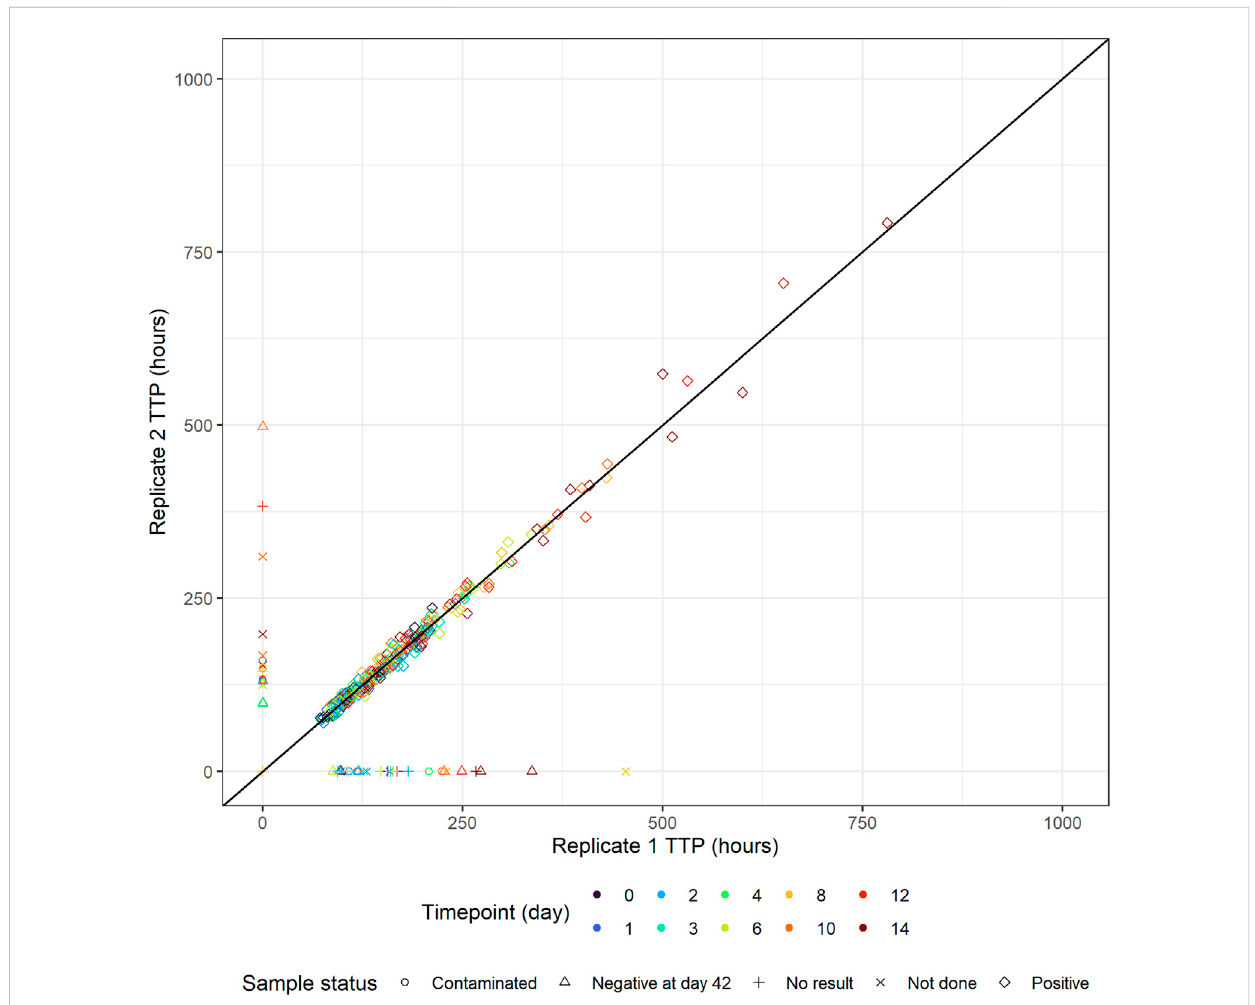
FIGURE 4 Individual time-to-positivity (TTP) replicate 1 versus individual TTP replicate 2. Observations are expected to be as close to the identity line as possible, and any clear deviations from the identity line should be investigated. Non-positive values are plotted in the fi gure axes and their symbol represents the corresponding sample status. For example, if replicate 1 is non-positive, the symbol with the corresponding replicate 2 value is plotted on the y -axis and vice versa